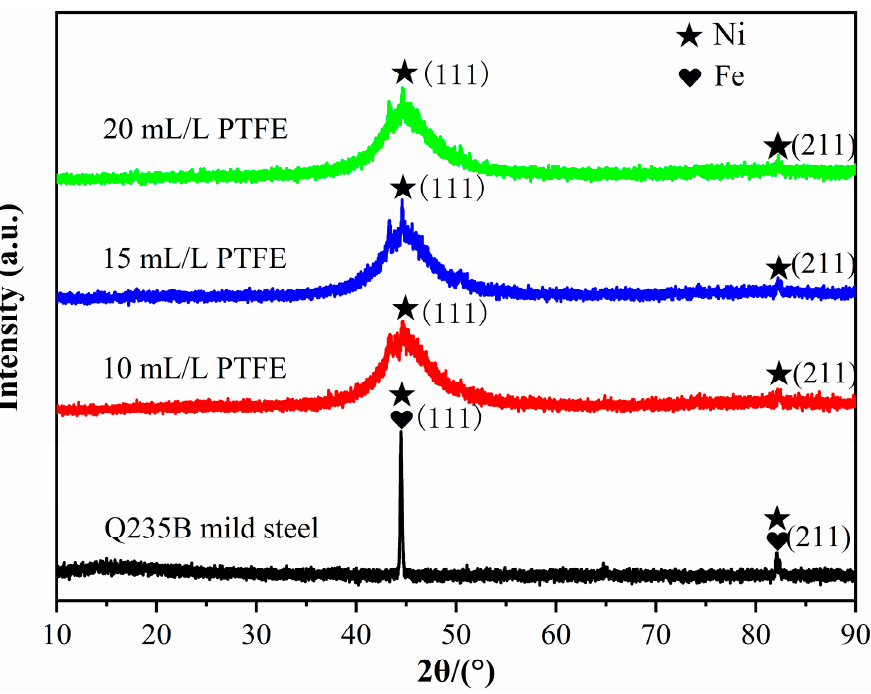
Figure 4. XRD patterns of Ni-Cu-P-PTFE composite plating of Q235B mild steel and different PTFE concentrations.